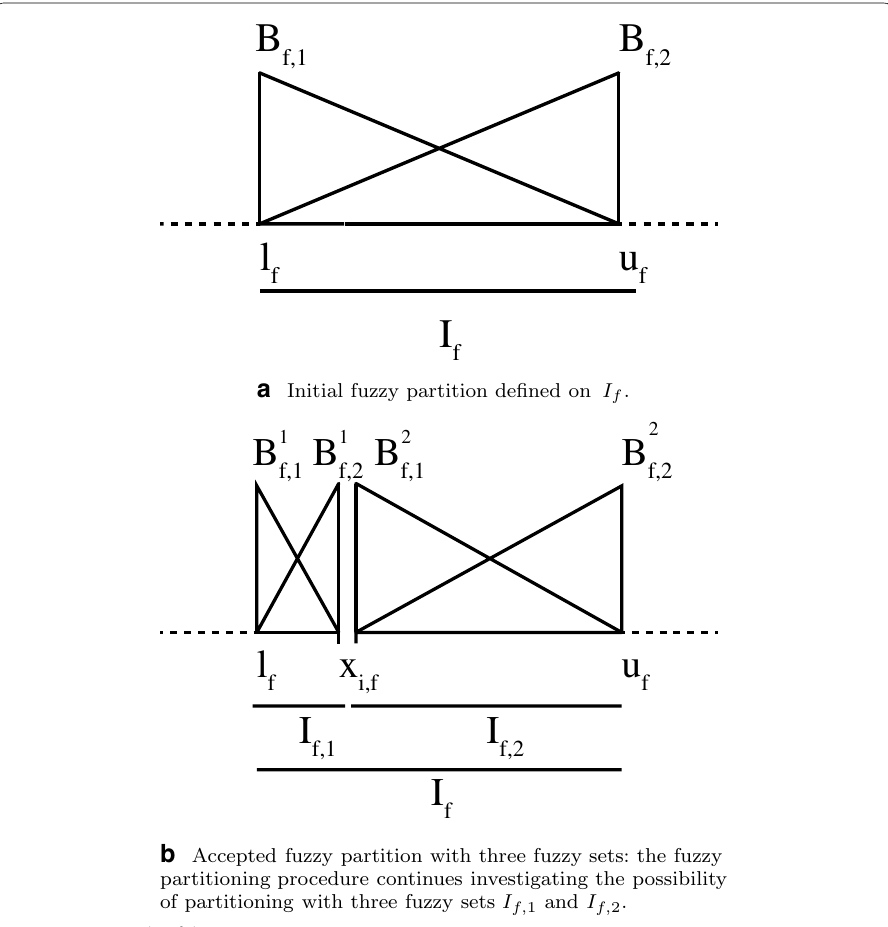
Fig. 2 An example of the iterative partitioning